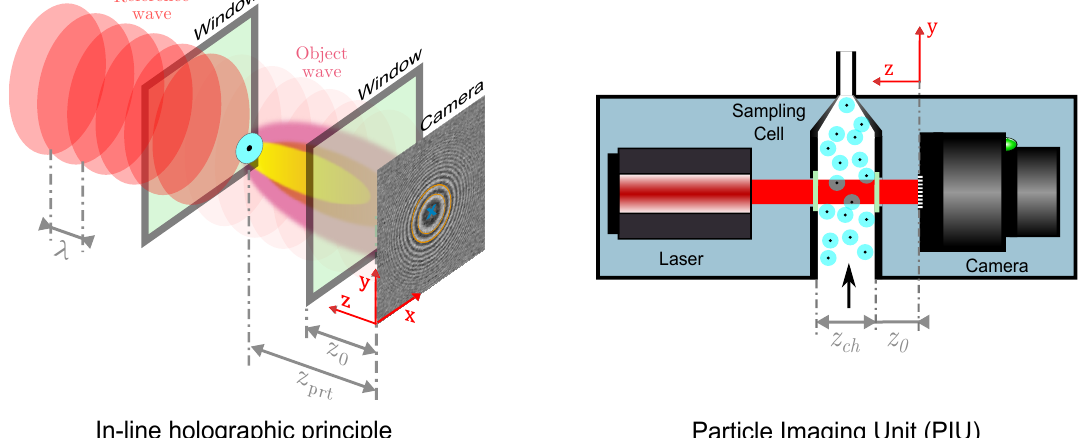
Figure 1. Left : in-line holographic principle where a single particle creates a fringe pattern at the camera plane. The detection is based on recognizing the set of concentric rings (in orange & blue); Right : schematic of the in-line holographic counting unit, subsequently called Particle Imaging Unit